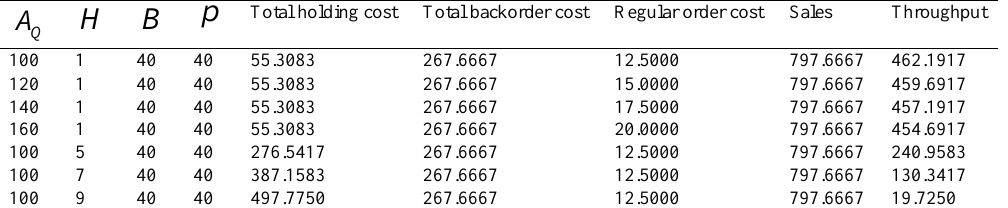
Table 4 Performance of adaptive (s,S,T) control